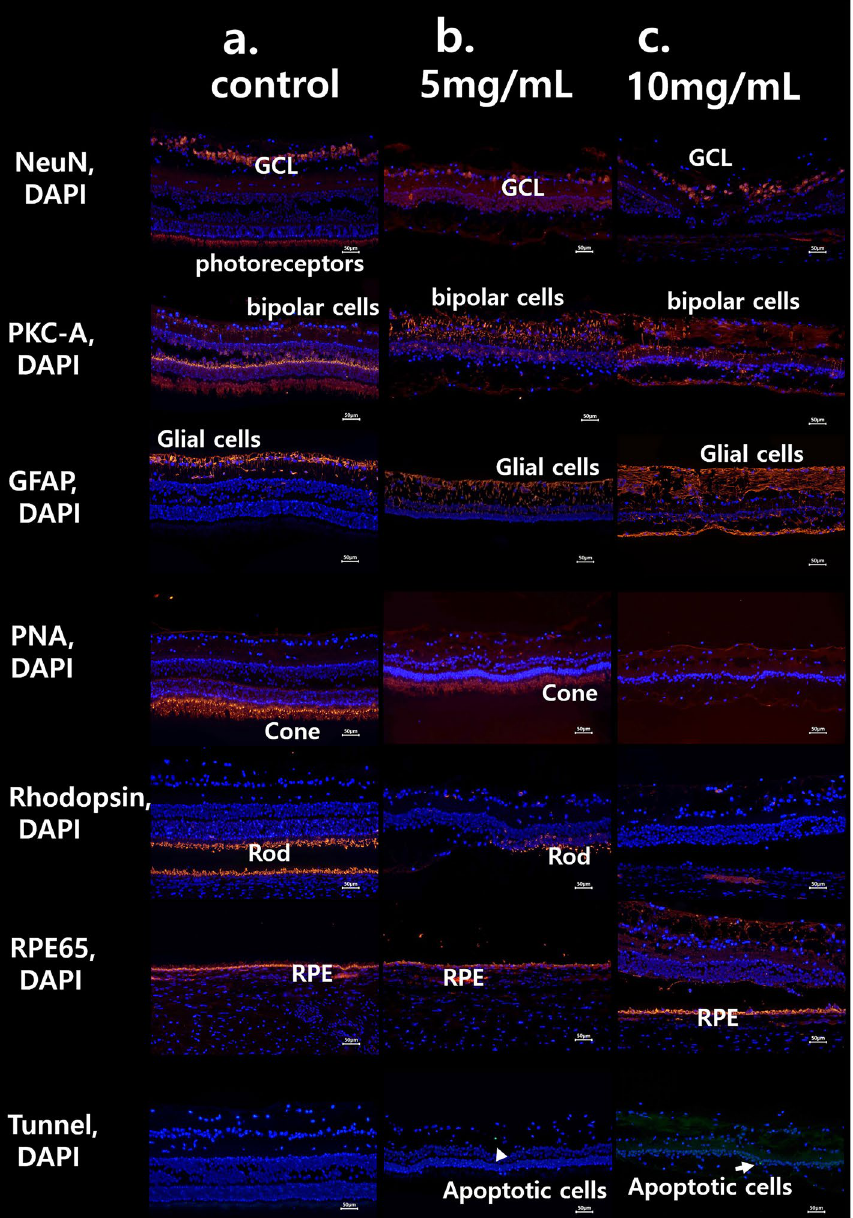
Figure 9. The immunohistochemistry findings of each representative case of 5 mg/mL MNU group and 10 mg/ mL MNU group. ( a ) The normal immunohistochemistry of a control case. Rhodopsin staining and PNA staining showed well-stained rod and cone cells (each percentage of the stained layer = 15.22% and 14.86%). ( b ) The immunohistochemistry of a representative case with moderate outer degeneration in the 5 mg/mL group. NeuN staining showed intact ganglion cells and the co-staining of photoreceptors. PKC-α staining showed intact bipolar cells, and GFAP staining showed nearly normal muller cells. Rhodopsin staining showed severely decreased rod cells, and PNA staining showed focal intact cone cells (each percentage of the stained layer = 4.11% and 14.15%). RPE65 staining showed intact RPE and rare co-staining of photoreceptors. There was no apoptotic cell in Tunnel staining. ( c ) The immunohistochemistry of a representative case with severe outer degeneration in 10 mg/mL group. NeuN and PKC-α stainings showed intact ganglion cells and bipolar cells, respectively. There was no co-staining of photoreceptors in NeuN staining. GFAP staining showed increased staining, especially in the outer retina. Rhodopsin and PNA staining showed relatively rare stained lesions of rod and cone cells (each percentage of the stained layer = 0% and 0%) with co-staining of RPE cells. RPE 65 staining showed intact RPE cells and Tunnel staining showed no stained lesions. RPE retinal pigment epithelium, GCL ganglion cell layer, IPL inner plexiform layer. Each percentage of the stained layers was evaluated by the stained area/all layer area using ImageJ software (1.53a version, National Institutes of Health, Bethesda, MD,